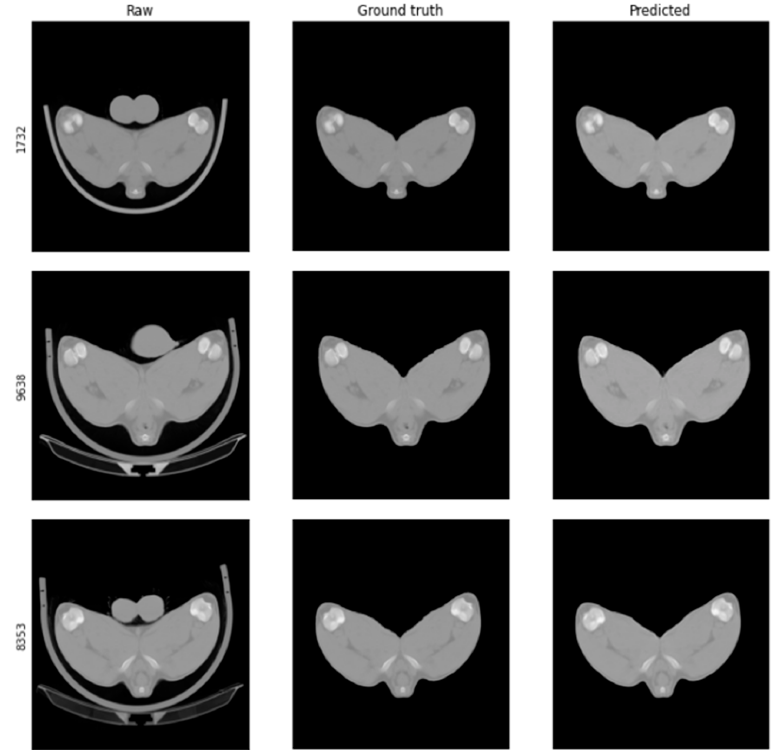
Figure 3. Representative comparison of raw, ground truth and predicted CT scan images. A trained generative adversarial network (GAN) was used to process raw CT images ( left column) into something resembling manually processed ground truth images ( middle column). Non-quantitative visual inspection of predicted results ( right column) indicated that images produced by this GAN are similar to ground truth counterparts. The GAN showed good capabilities in automatically handling